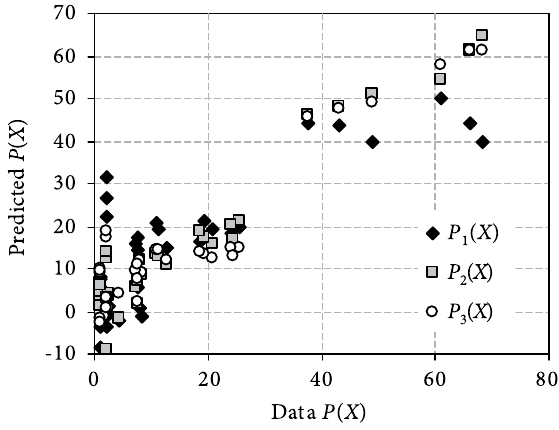
fig. 5. A comparison of factual and predicted LPG consumption in transport